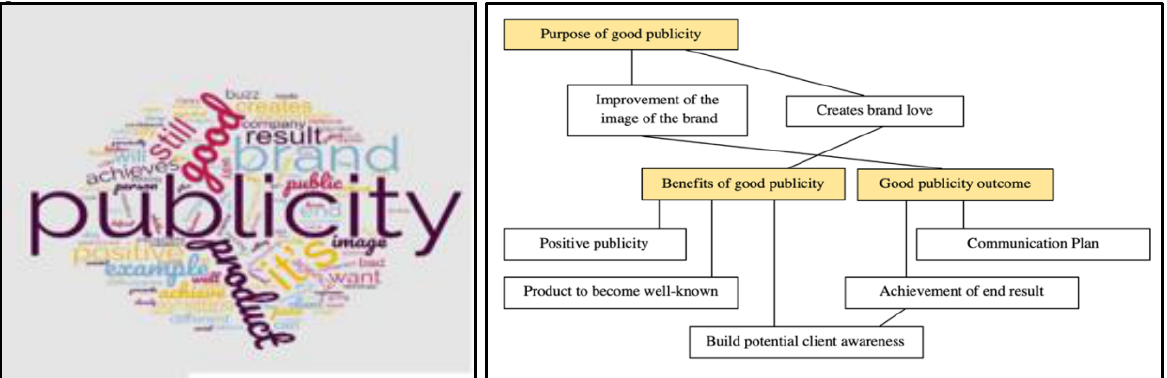
Figure 12: Thematic Map of Good Publicity Figure 11: Definition of Good